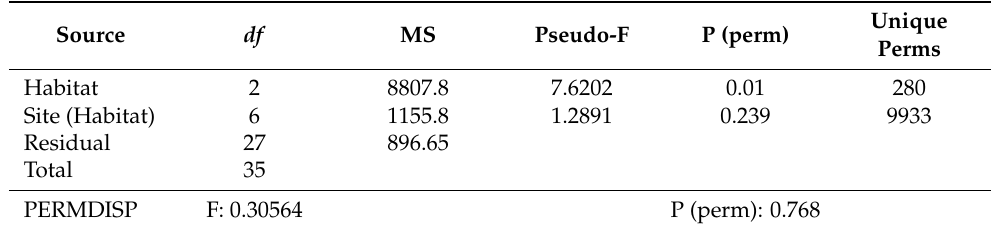
Table 2. Permutational multivariate analysis of variance (PERMANOVA) of scavenging megafaunal assemblages.